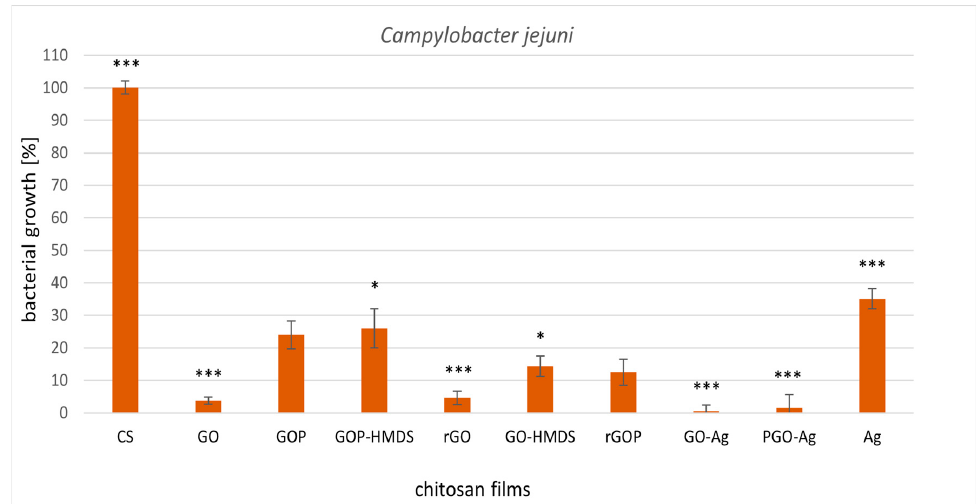
Figure 3. Reduction of Listeria monocytogenes ATCC 15313 with treatments with metal ‐ oxide chitosan films after 24 h incu ‐ bation. The value from control group (CS) was set as 100%. Statistical significance is marked in relation to the chitosan